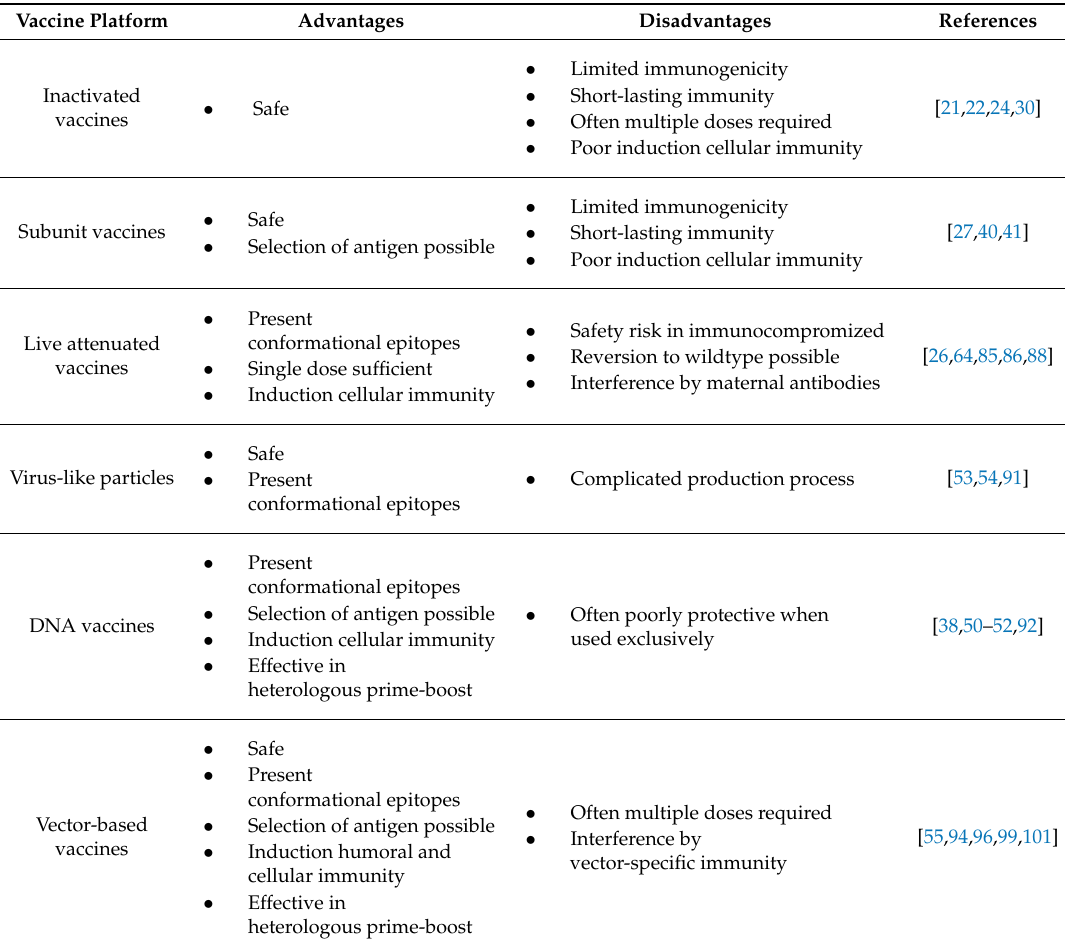
Table 1. Advantages and disadvantages of various vaccination